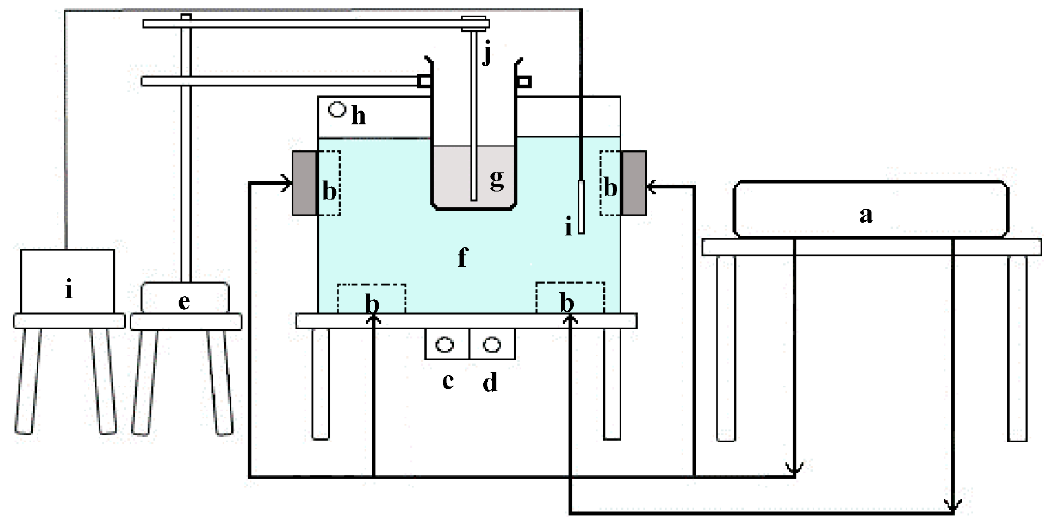
Figure 2. Experimental setup for indirect thermosonic-assisted extraction. ( a ) Ultrasonic generator, ( b ) transducer, ( c ) water inlet valve, ( d ) water drain valve, ( e ) retort stand, ( f ) ultrasonic tank, ( g ) fruit juice, ( h ) overflow outlet, ( i ) heater, and ( j ) temperature probe.